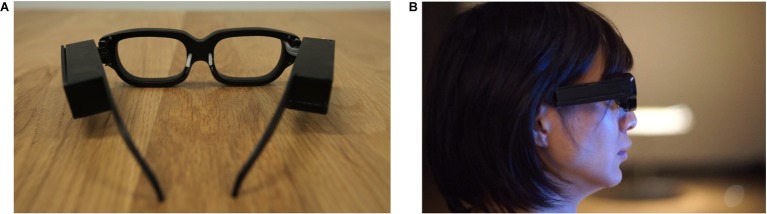
Teardrop glasses, by Yoshida (2015), http://www.shigeodayo.com/tear_drop_glasses.html.